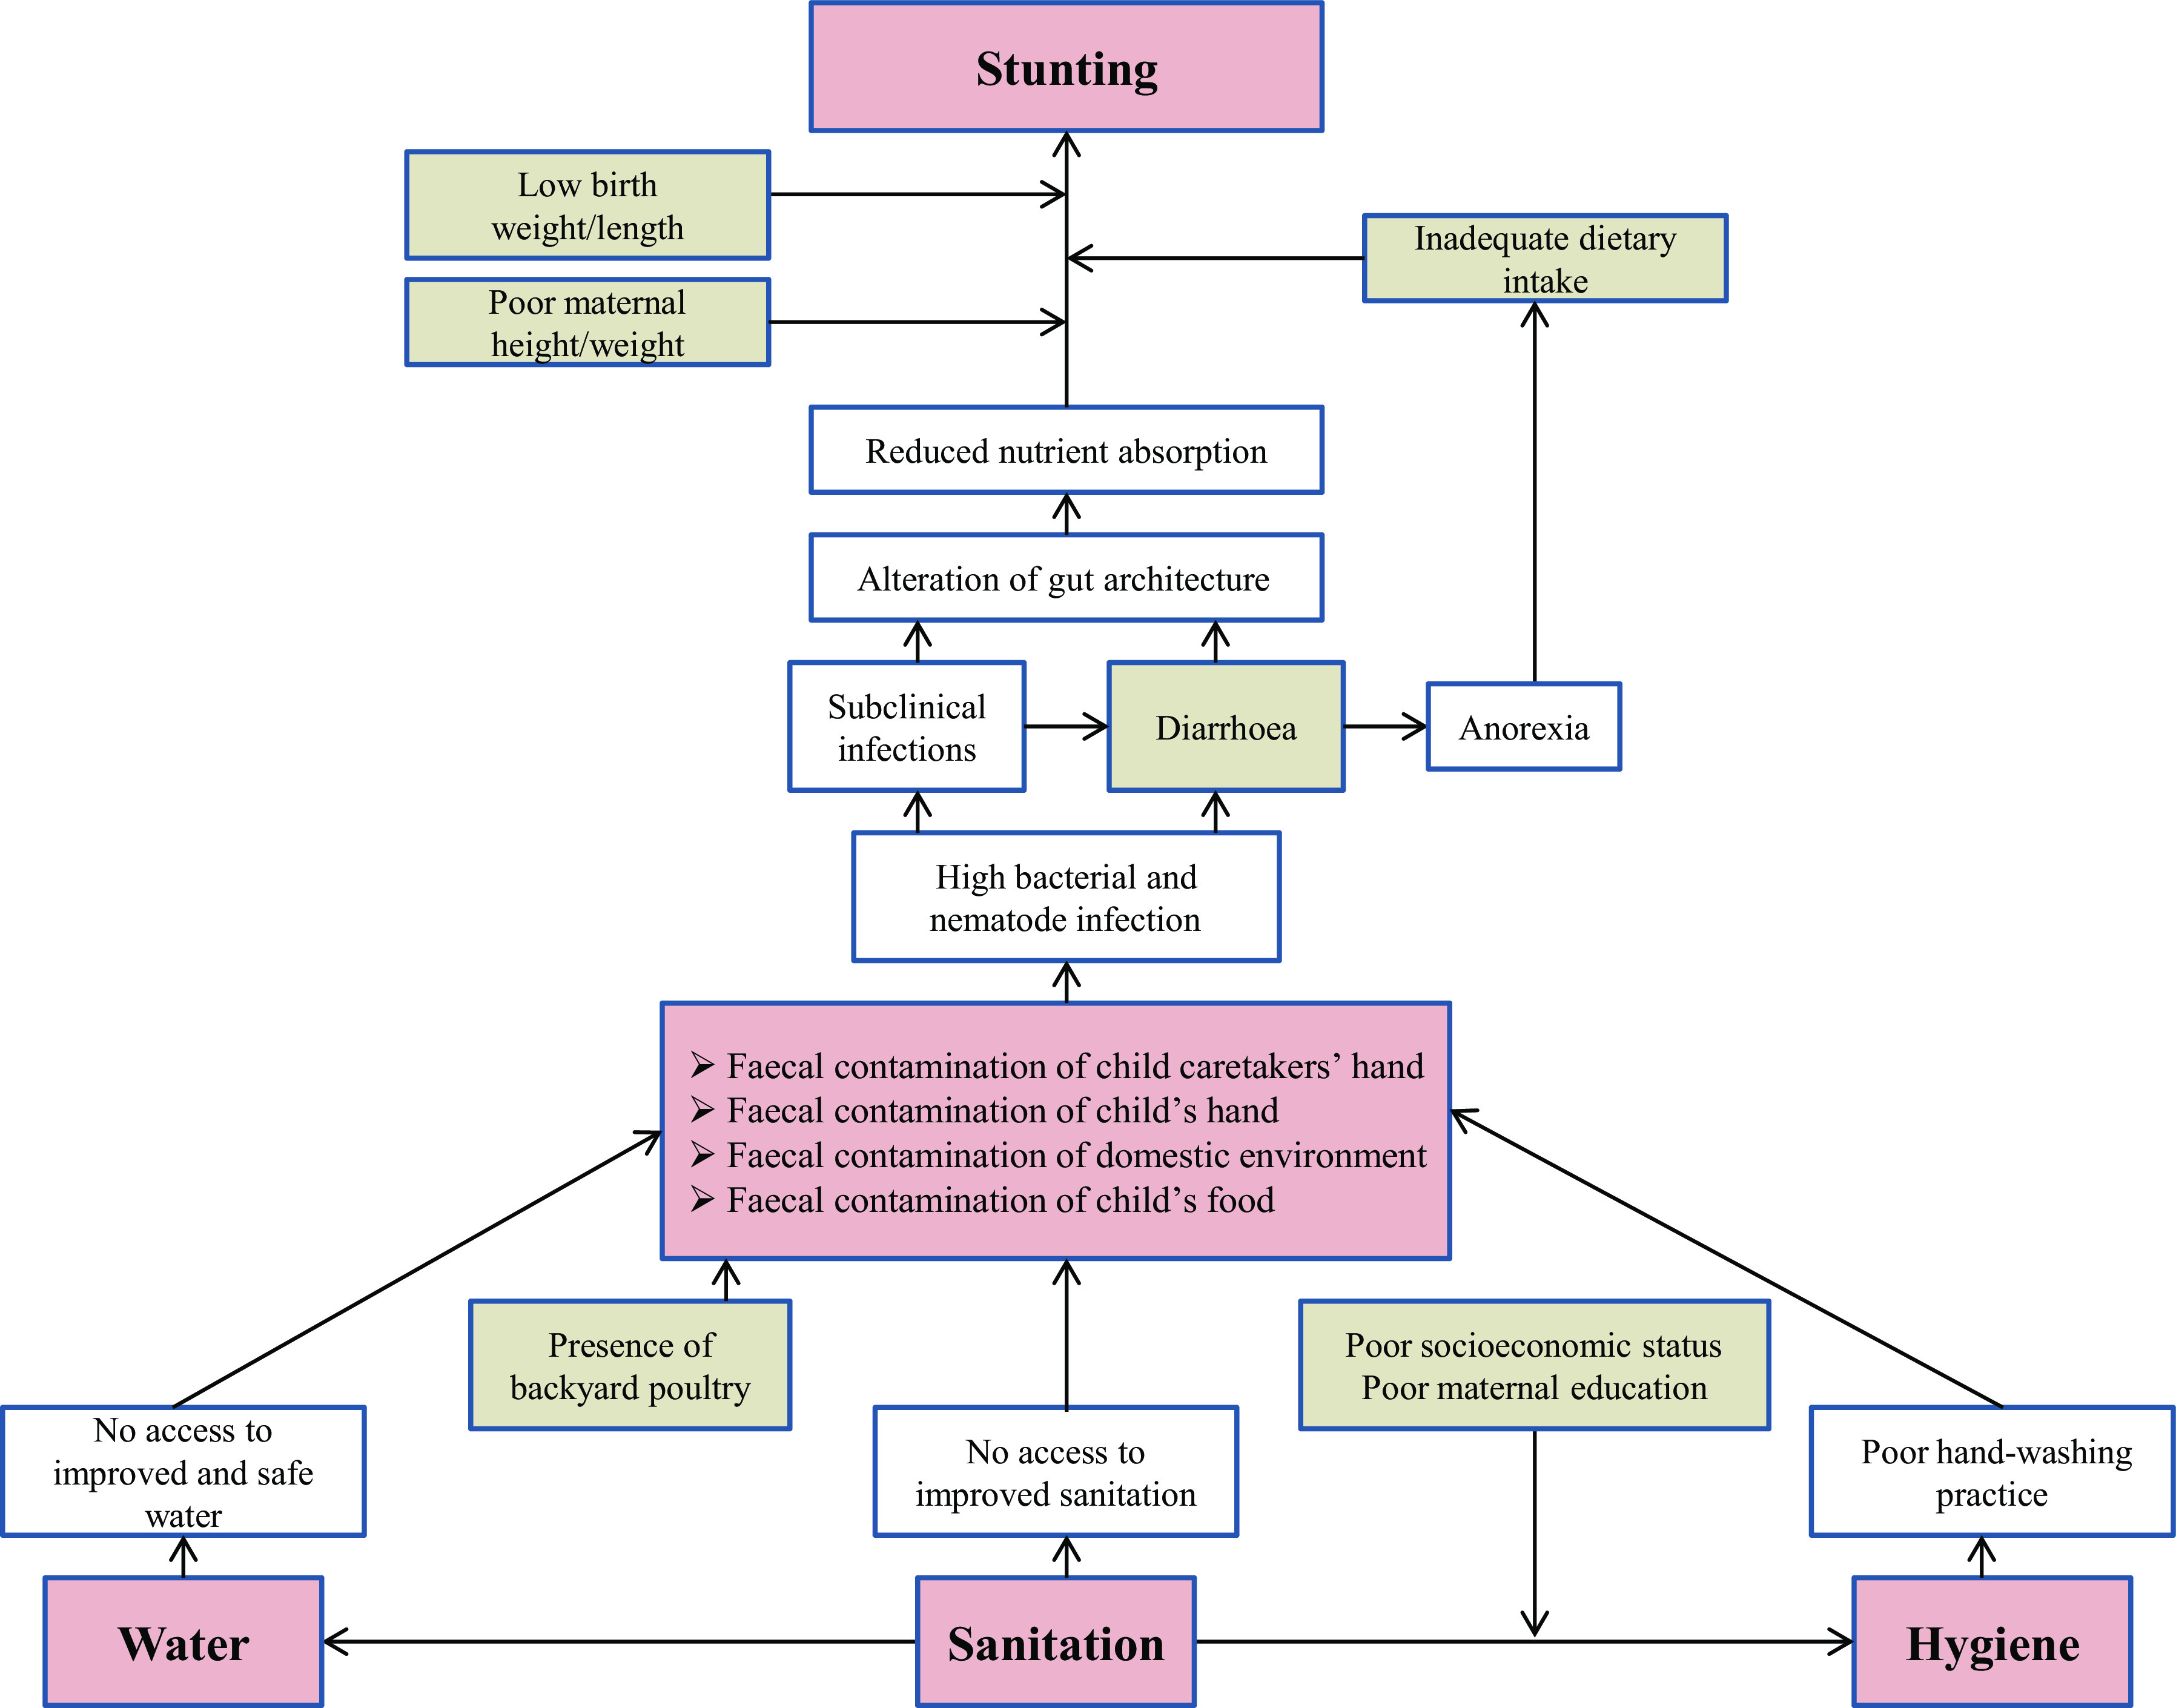
Conceptual framework depicting the water, sanitation and hygiene (WASH)–stunting causal pathway